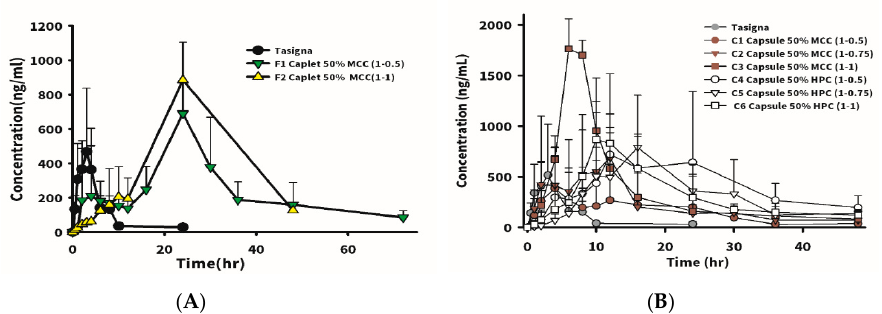
Figure 4. Plasma nilotinib concentration profiles after oral administration of F1 and F2 formulations ( A ) and C1–C6 formulations (mean ± standard deviation, n = 2 or 3) ( B ). The commercially available product, Tasigna, was included for comparison.